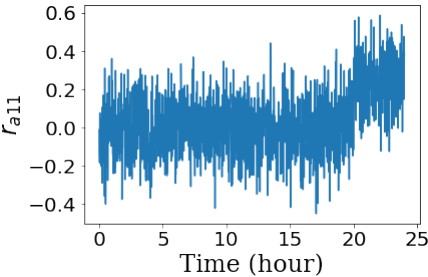
Figure 13. Residual r a 11 for 24 h when each sensor in the ADAPT-Lite system has an additive noise with a normal distribution, N ( 0.0.1 ) , and f E 240 = 0.25 occurs at t = 20 h.